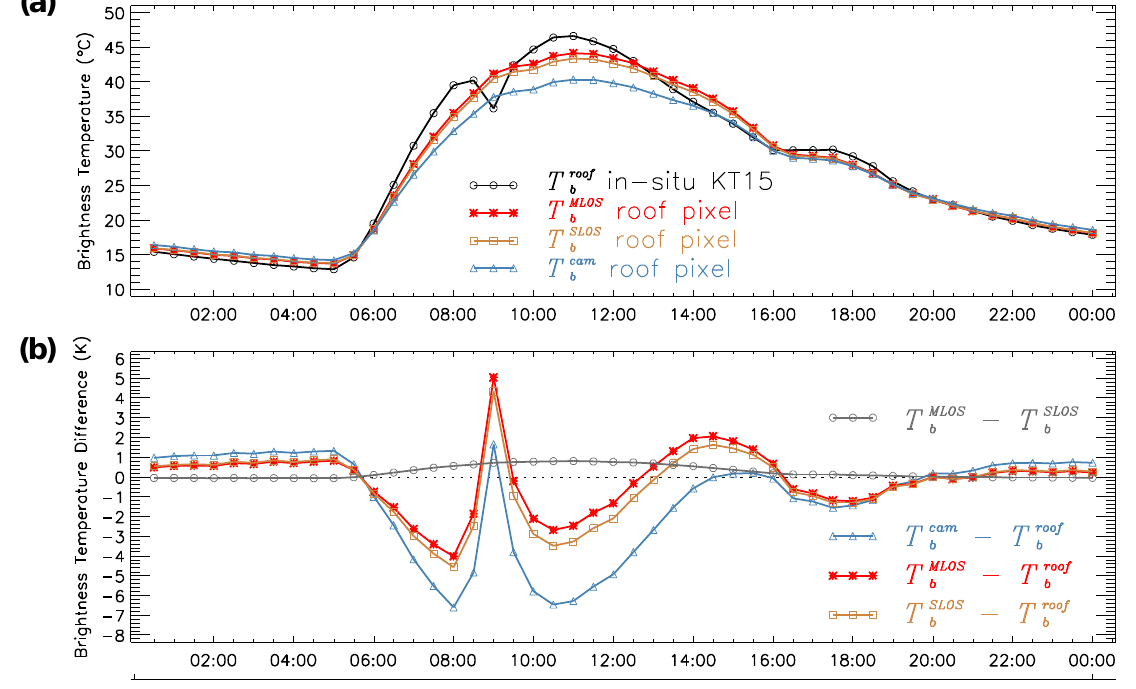
) and (b) variation of difference , T MLOS , T SLOS b b b and T SLOS during 6 August b b